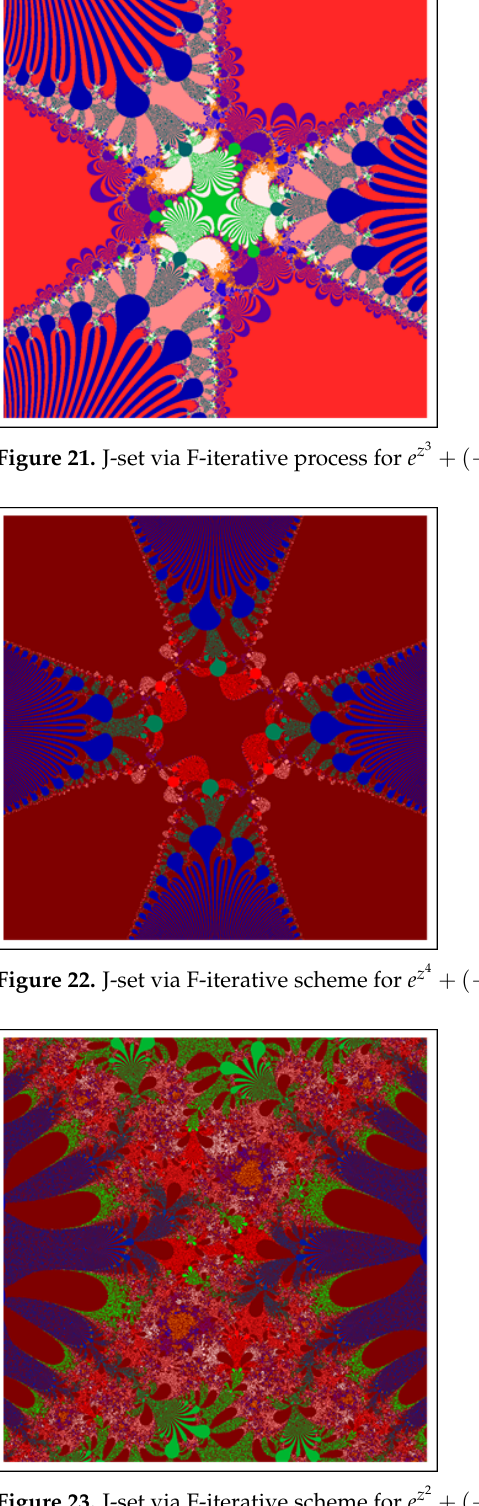
Figure 23. J-set via F-iterative scheme for e z 2 + ( − 0.5 i ) with image visual time = 1209